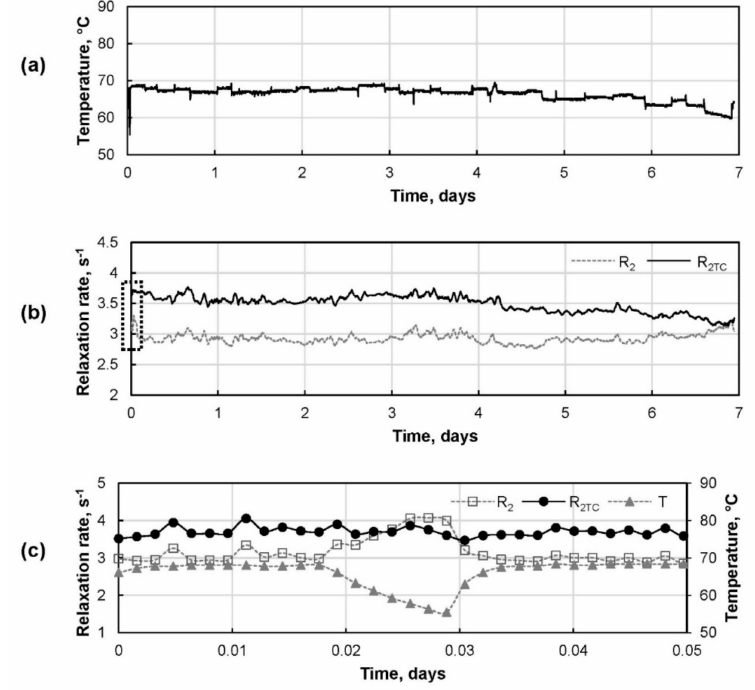
Figure 4. Data measured for the weak black liquor in the online test: ( a ) Sample temperature; ( b ) Measured R 2 values and values of the R 2TC corrected to T ref = 60 ◦ C, after applying a one-hour moving average; ( c ) Temperature correction at the beginning of the test (dotted rectangle in Figure 4b): measured R 2 (squares), values of the R 2TC corrected to T ref = 60 ◦ C (circles), and the sample temperature T (triangles).